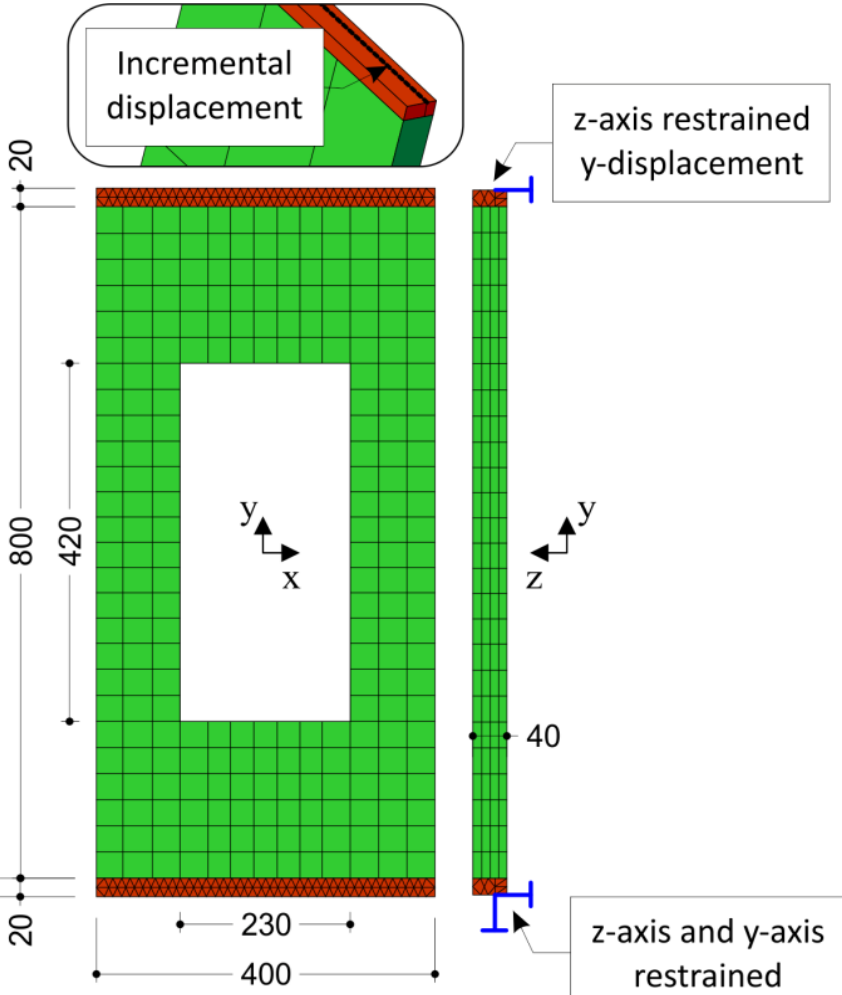
Figure 4. Typical model developed of OW